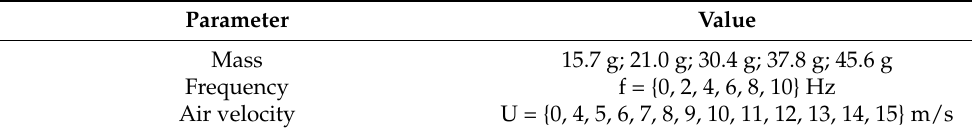
Table 4. Experiment